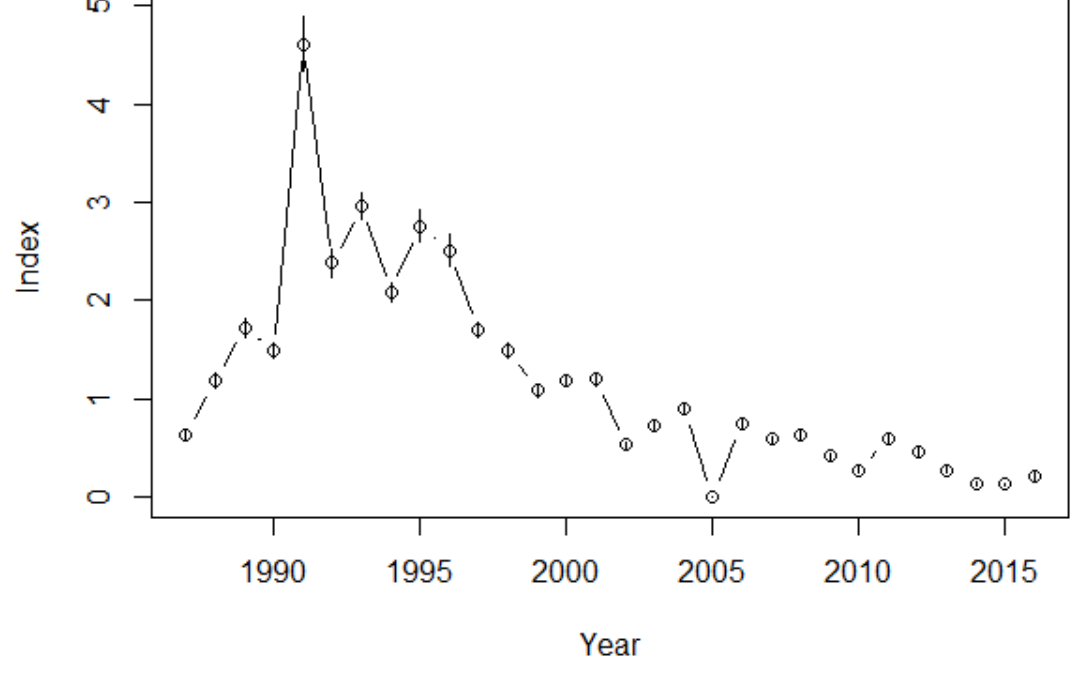
Figure 33. Index of relative abundance of horseshoe crab (delta mean catch per tow) developed from the fall portion of the New York DEC Peconic Bay Small Mesh Trawl Survey with 95% confidence